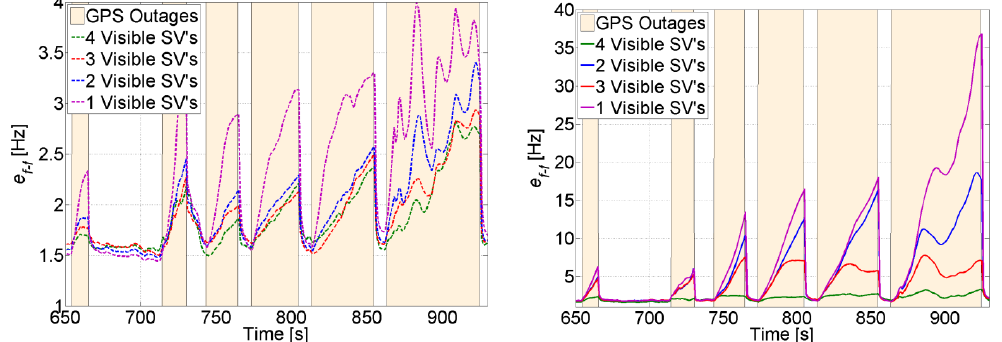
Figure 20. Feed-forward frequency uncertainty for the visible SV 19 ( left ) and the non-visible SV 11 ( right ).